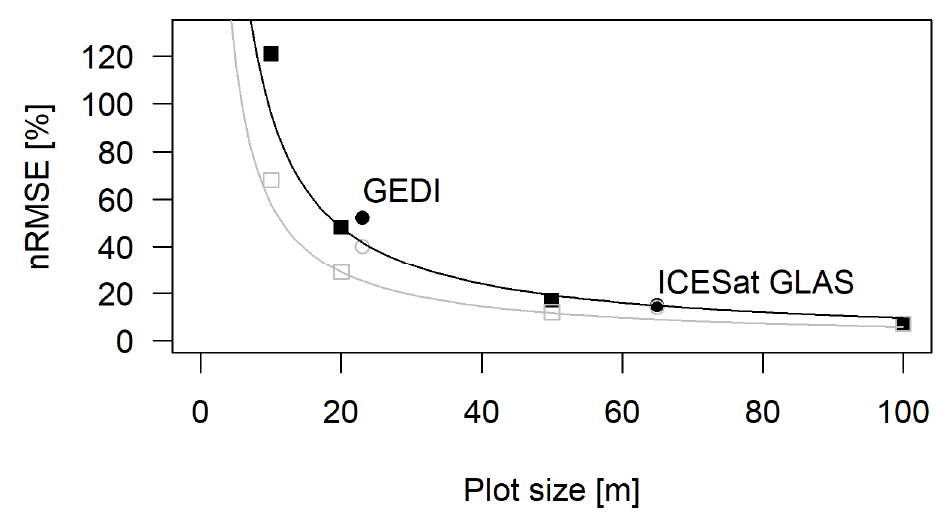
Figure 6. Summary of the ways in which the normalized root mean square error (nRMSE) scales for biomass estimations from CHM (squares) and large-footprint waveforms (circles) with border effects (black filled) and without border effects (grey open). The curves represent the theoretical scaling behavior according to which the errors decline by (plot area) − 1/2 or (plot side length) − 1 [32]. The curves were drawn to match the nRMSE at the 20-m scale exactly, and they approximate the observed nRMSE at the other scales well.